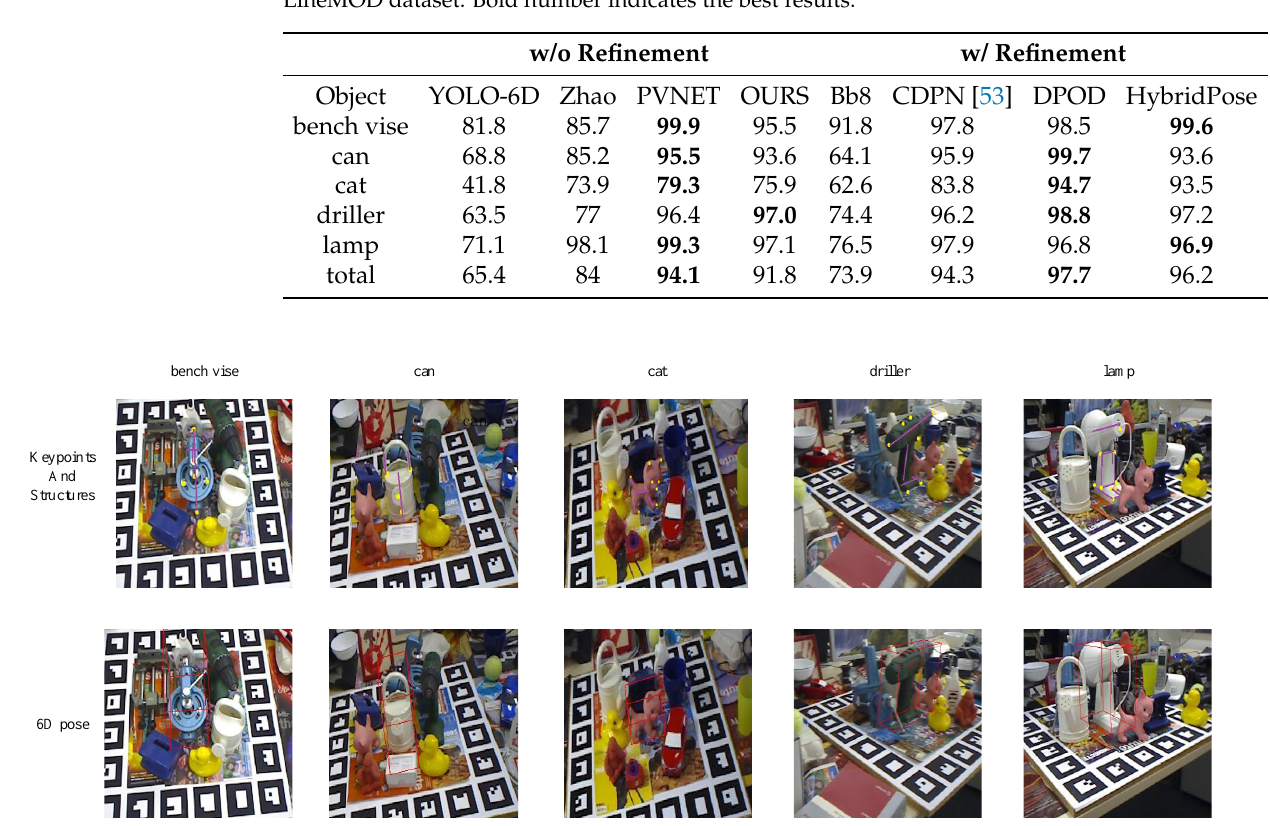
Figure 16. Qualitative results for the proposed method on LineMOD dataset. The yellow points are the keypoints and the purple segments are the